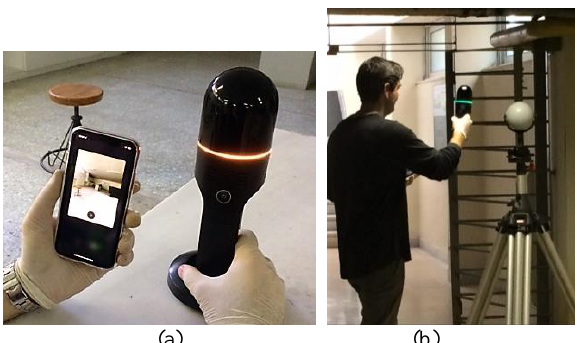
Figure 1. Basic concept of SLAM algorithm (after Reid, 2016) Figure 2. Use of BLK2GO during (a) initialization (b)